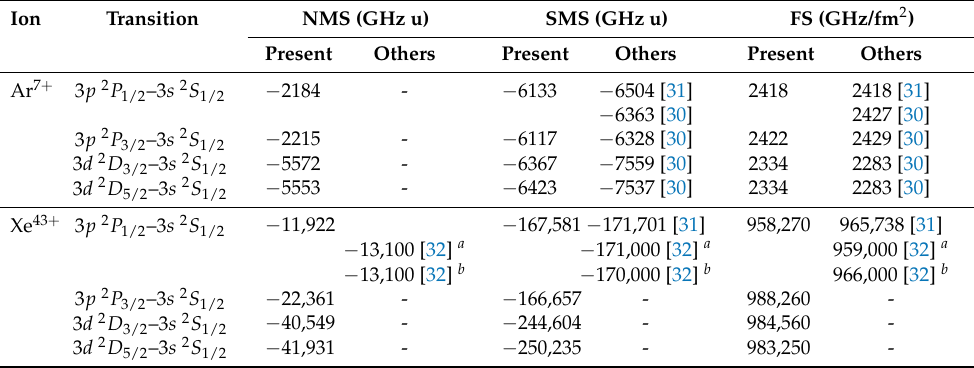
Table 8. The normal mass shift (NMS), specific mass shift (SMS) and field shift (FS) values from the present work and the results of Safronova and Johnson [30] , Tupitsyn et al. [31] and Silwal et al. [32].